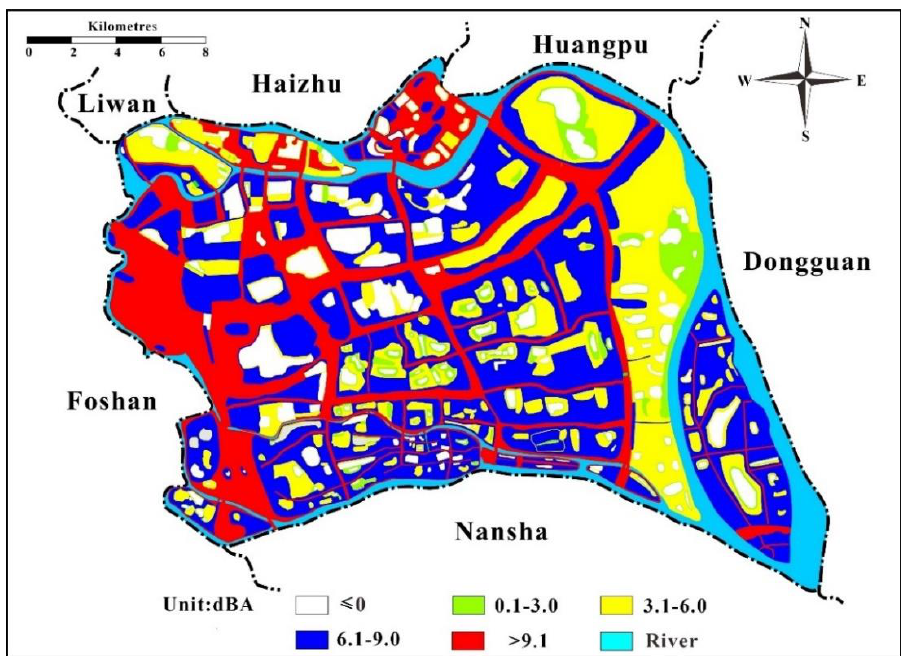
Figure 2. Nighttime over-limit value map in Panyu District of Guangzhou